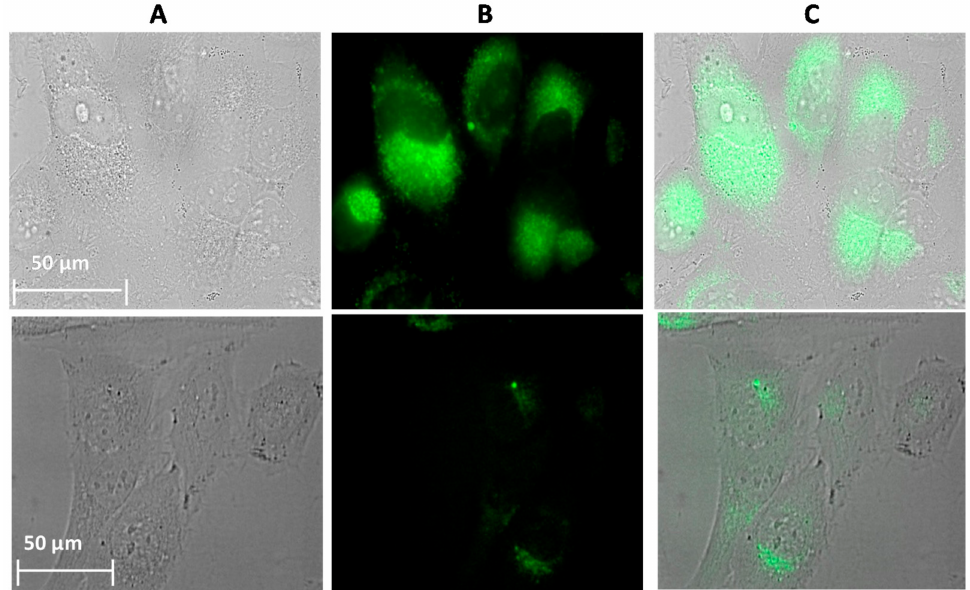
Figure 2. Results of epifluorescence microscopy experiments on living HeLa cells. (Top) after 1 h and 30 min of incubation with a 210 µ M solution of the 4i probe. (Bottom) Untreated cells as a control. ( A ) Brightfield. ( B ) Fluorescence. λ ex: 417 nm band pass 60 nm filter, λ em: 536 nm band pass 40 nm, τ exp: 500 ms. ( C ) Merged. 40 ×